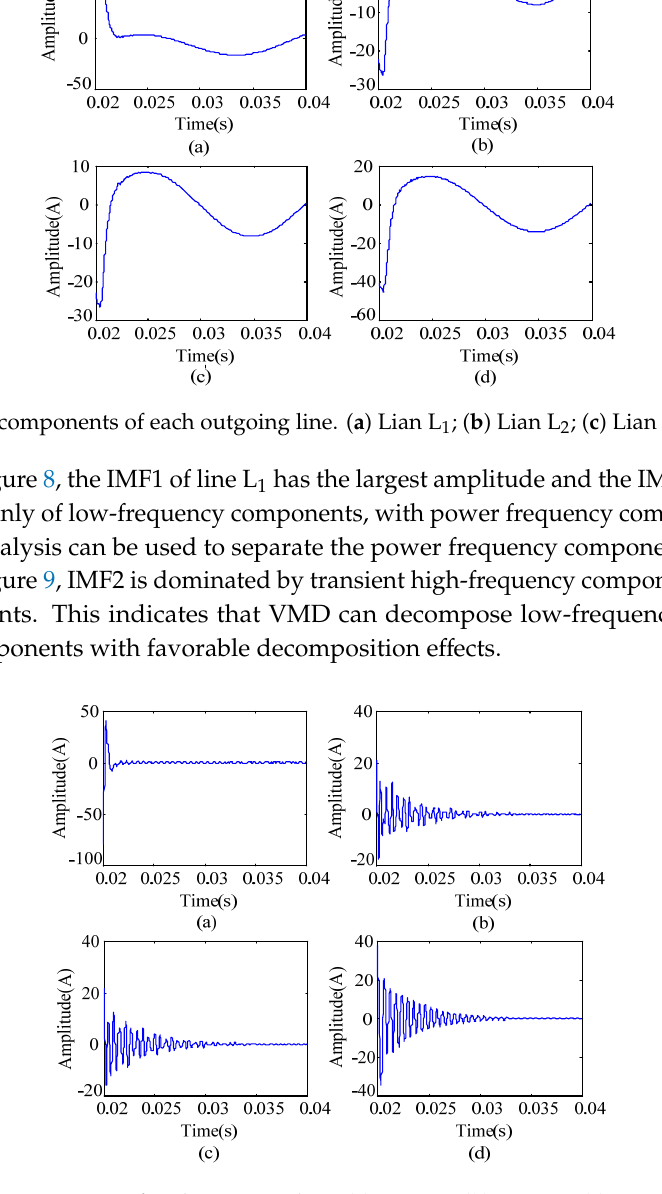
Figure 7. TZSCs for SPG fault. ( a ) Lian L 1 ; ( b ) Lian L 2 ; ( c ) Lian L 3 ; ( d ) Lian L 4 .